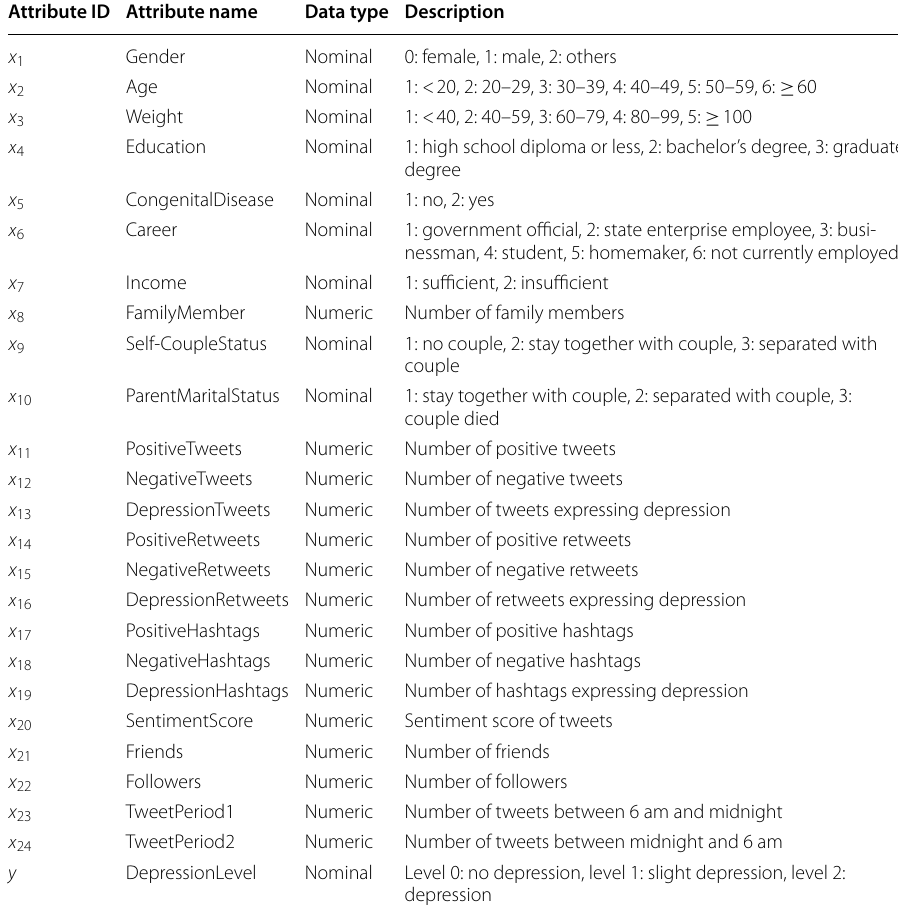
Table 2 Data characteristics of relevant